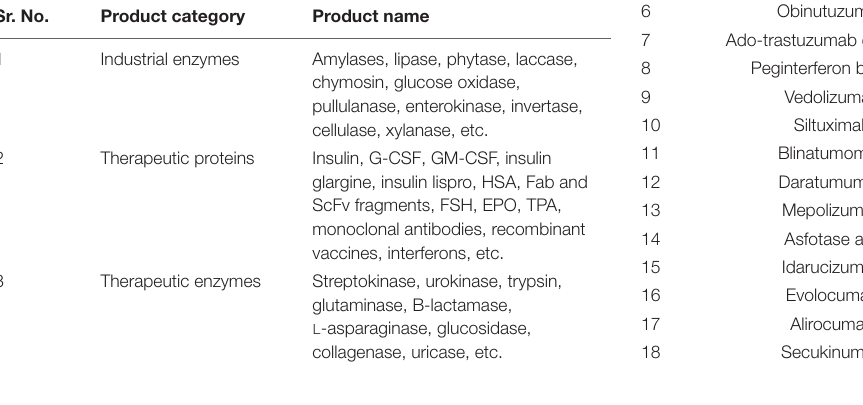
TABLE 1 | Recombinant Proteins produced by different hosts (Olempska-Beer et al., 2006; Fakruddin et al., 2013; Gupta and Shukla, 2015; Mane and Tale, 2015 and www.fda.gov).